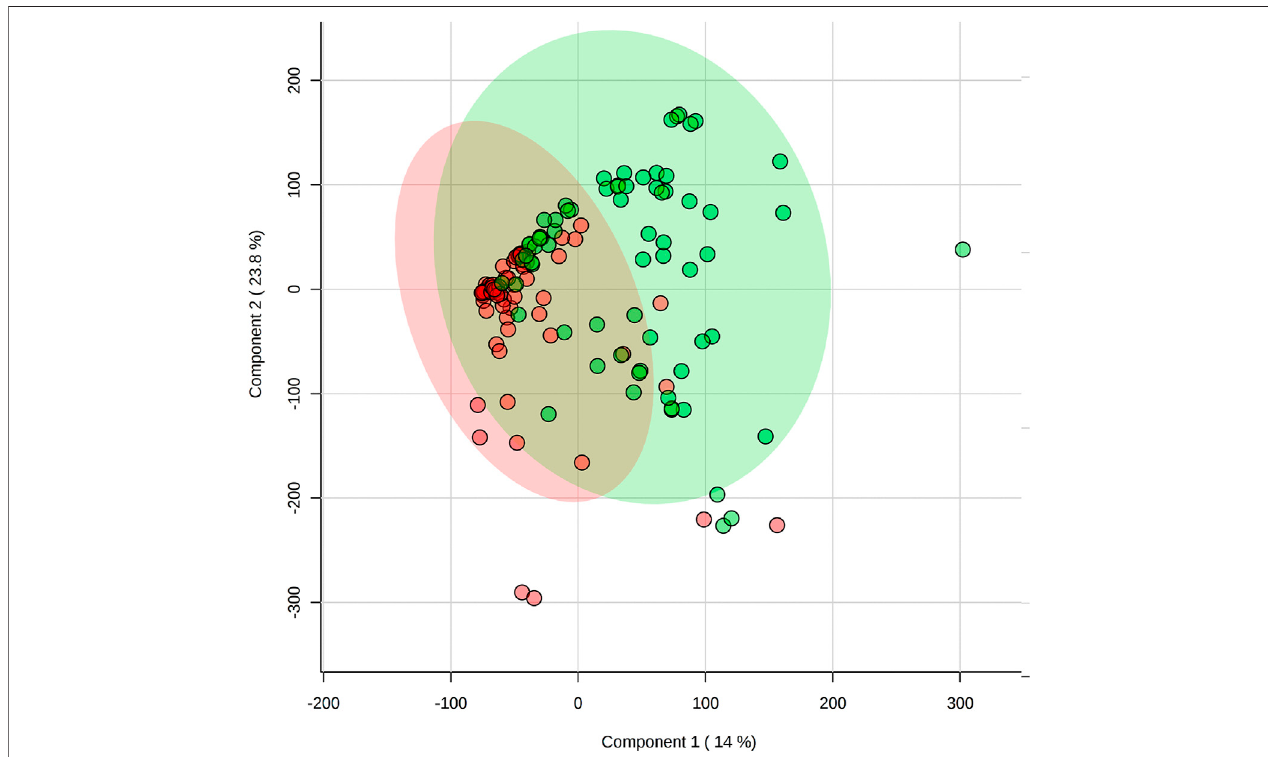
FIGURE 2 | Comparison of pre-game metabolomes (metabolic pro fi le) between backcourt and frontcourt players during elite male basketball games using partial least square discriminant analysis. Red: backcourt, green: